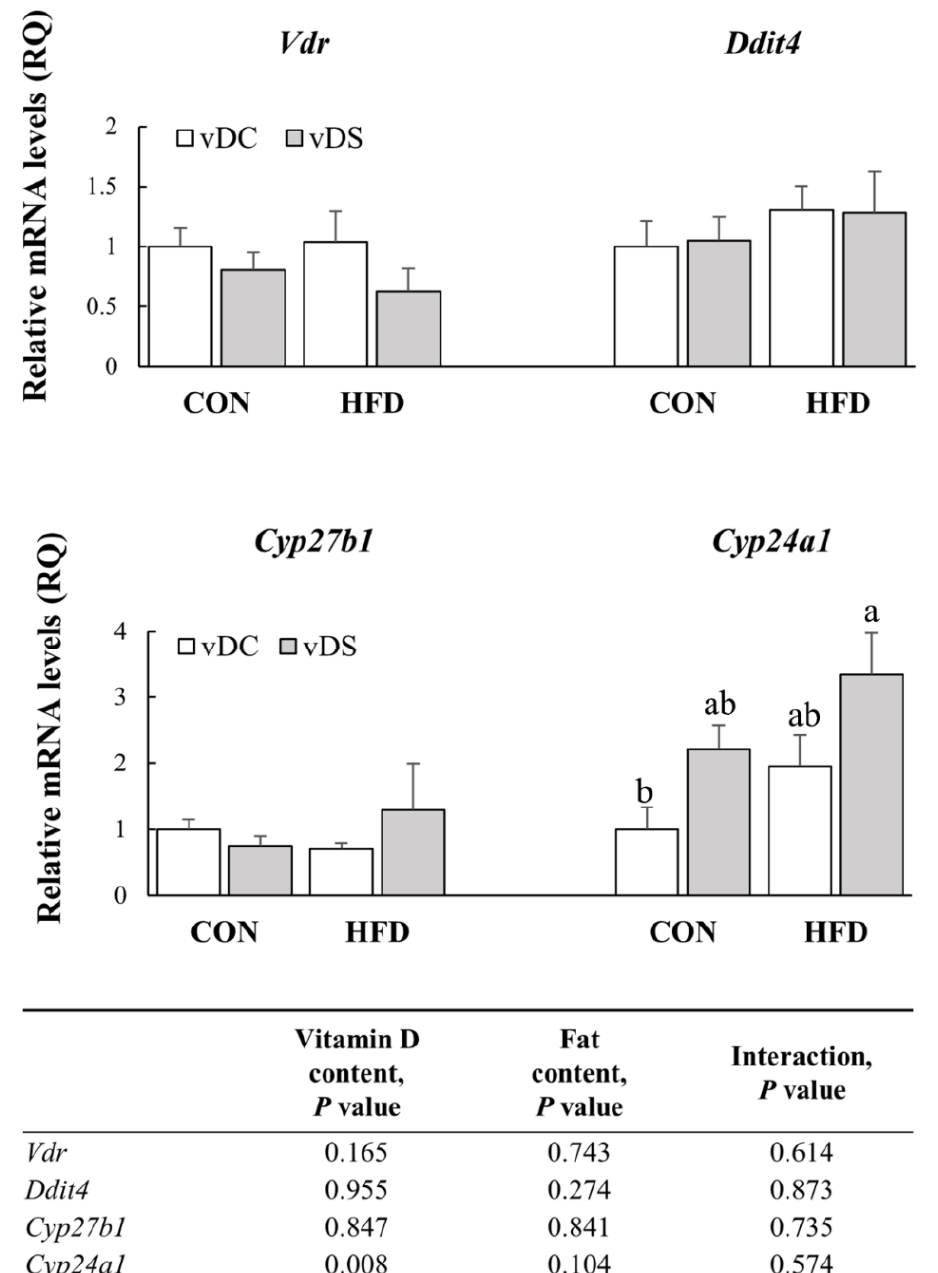
Figure 5. mRNA levels of Vdr , Ddit4 , Cyp27b1, and Cyp24a1 in T cells. Splenic T cells were stimulated with anti-CD3/anti-CD28 mAbs for 48 h, and the mRNA levels of Vdr , Ddit4 , Cyp27b1 and Cyp24a1 were determined by qPCR. Data are presented as means ± SEMs, n = 7–9 per group. Two-way ANOVA was used to determine the significant effects of fat and vitamin D contents, and an interaction. a,b Different superscripts indicate significant difference ( p < 0.05) among individual groups by Fisher’s least significant difference multiple comparison test. All values were normalized to the levels of housekeeping gene Gapdh and expressed as relative mRNA levels, compared with the average levels of the CON-vDC group. CON-vDC, 10% kcal fat diet + vitamin D control; CON-vDS, 10% kcal fat diet + vitamin D supplemented; HFD-vDC, 45% kcal fat diet + vitamin D control; HFD-vDS, 45% kcal fat diet + vitamin D